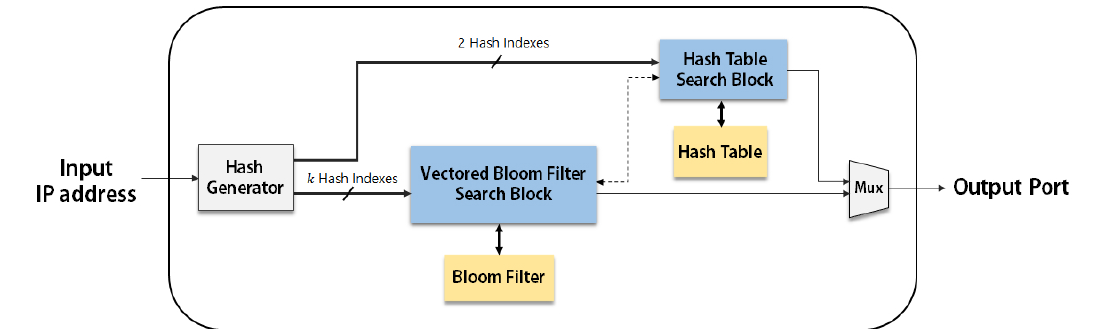
Figure 2. Block diagram of Basic IP Address Lookup Module : the bold lines represent data paths and the dotted line represents a control path.